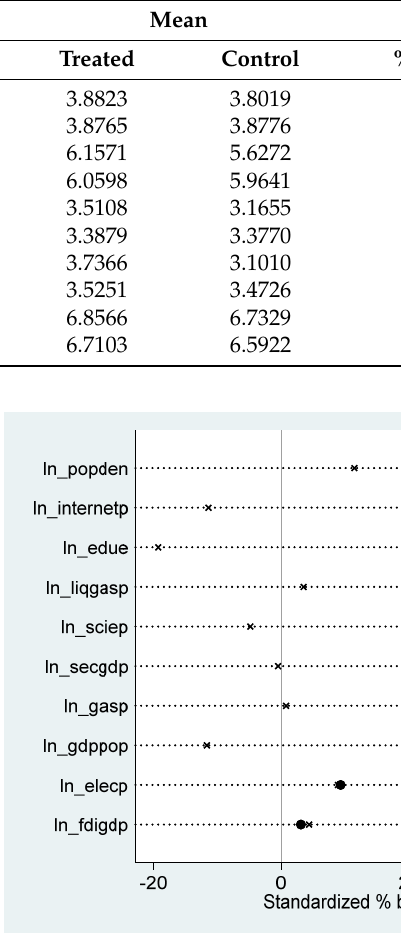
Figure 5. Standardized deviation of variables before and after PSM treatment (2015). Table 4. Deviation and confidence level before and after PSM